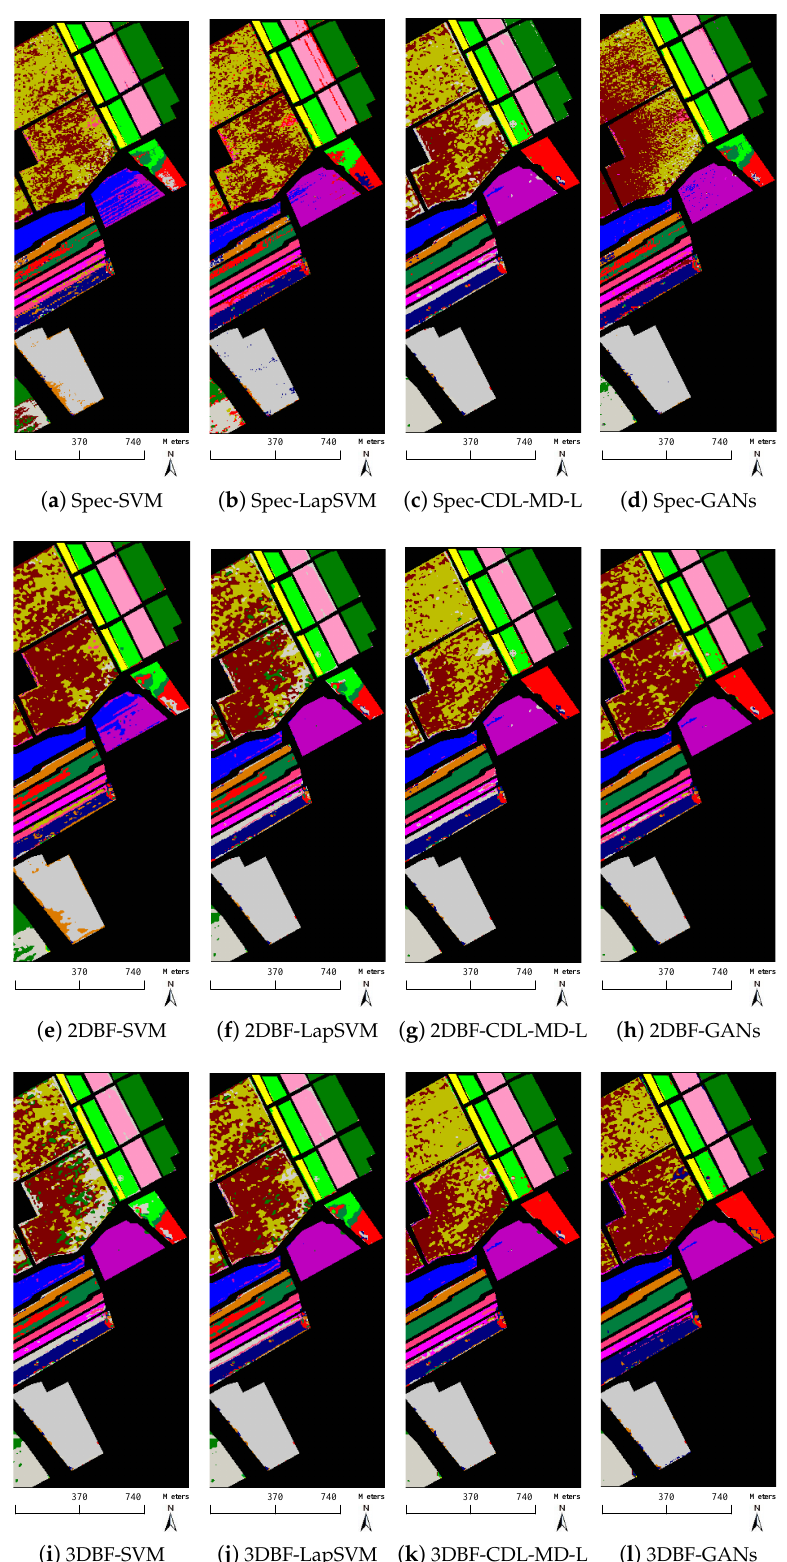
Figure 13. Classification maps of the Salinas data with 5 samples per